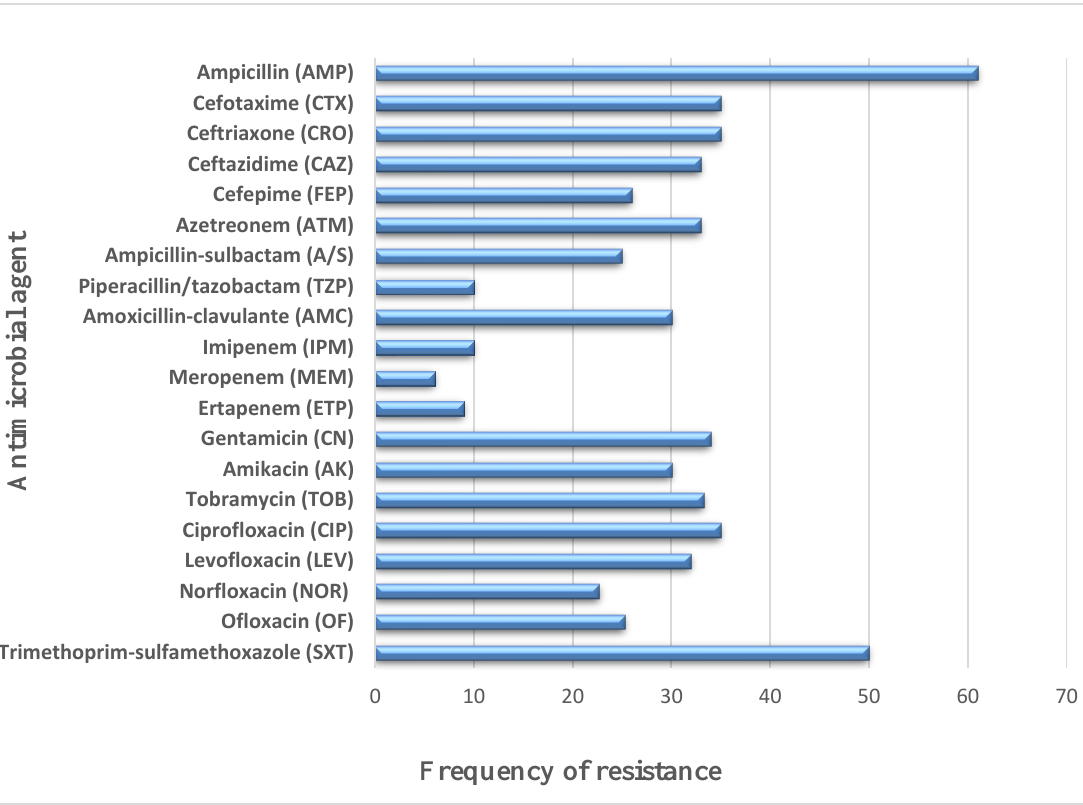
Figure 1. Frequency of antibiotic resistance within the 100 P. mirabilis isolates, R isolates include (intermediate + resistant).